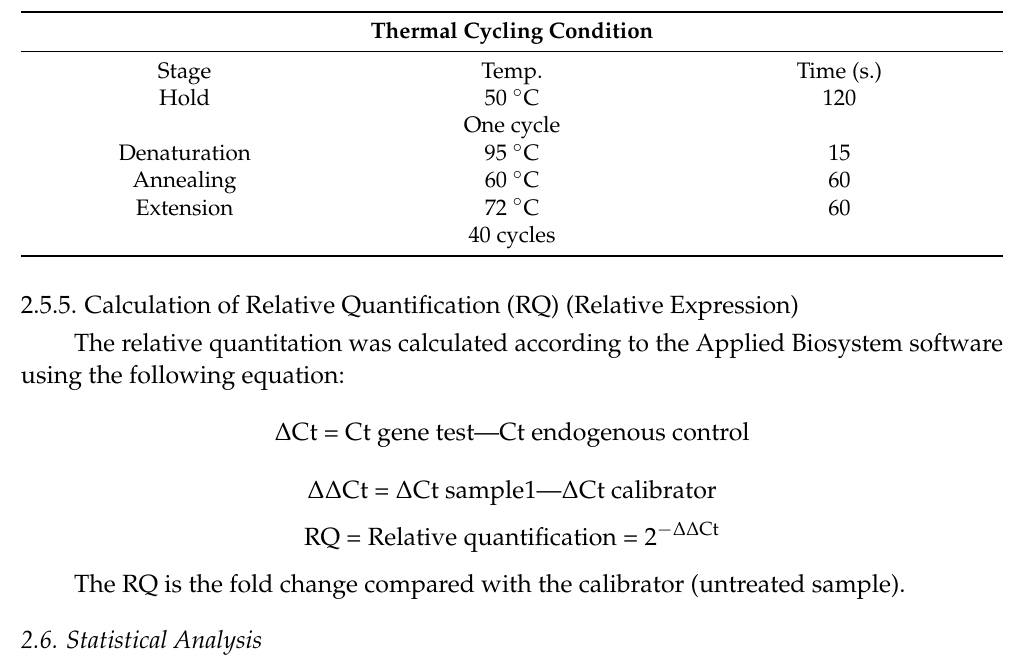
Table 4. Running condition for